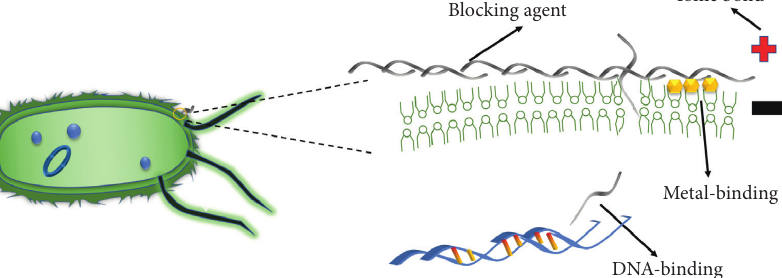
Figure 3: Hypothesis of bacteriostatic mechanism of chitosan.